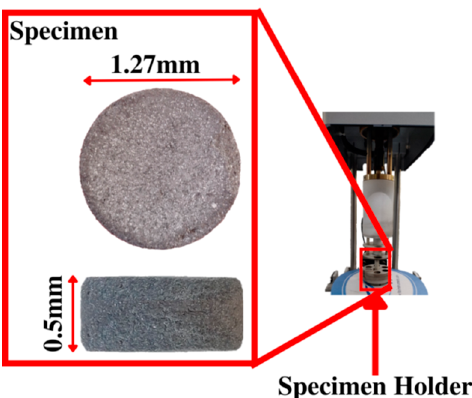
Figure 4. Workpiece for measuring thermal conductivity.